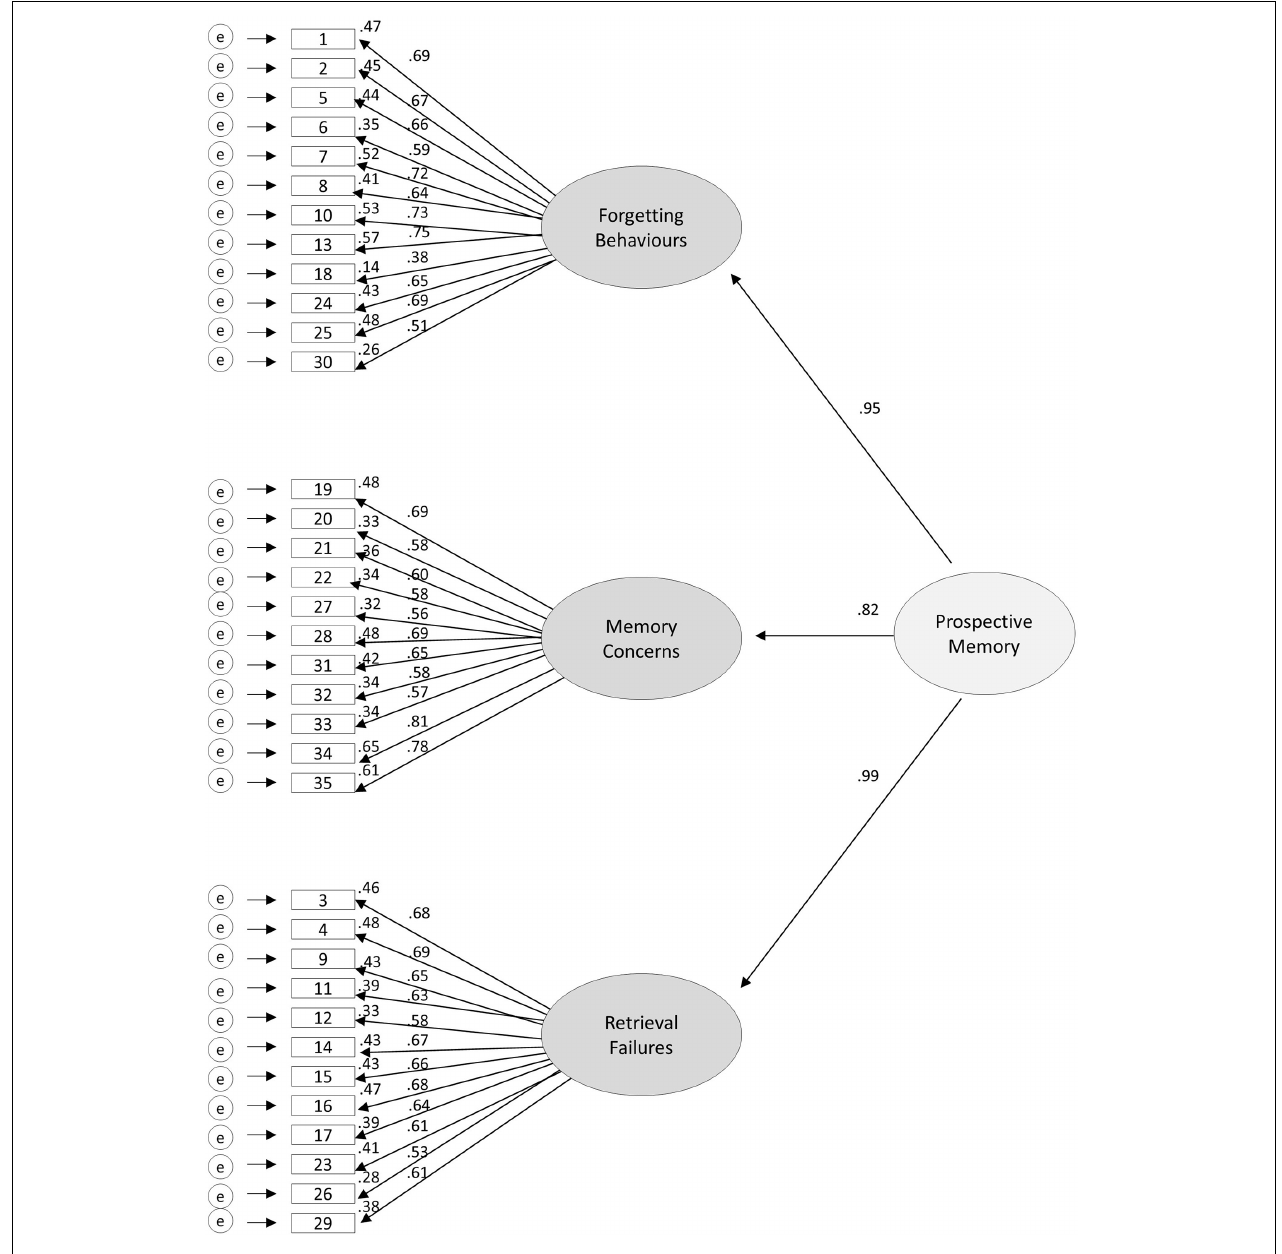
FIGURE 1 | Higher order three-factor model of the Prospective Memory Concerns Questionnaire (PMCQ). Items are shown in the boxes on the left, factors are shown in the ovals, the lines illustrate the standardized loadings for factors, and the numbers at the top right of each item represents the squared multiple correlations or variance accounted for ( R 2 ) for each